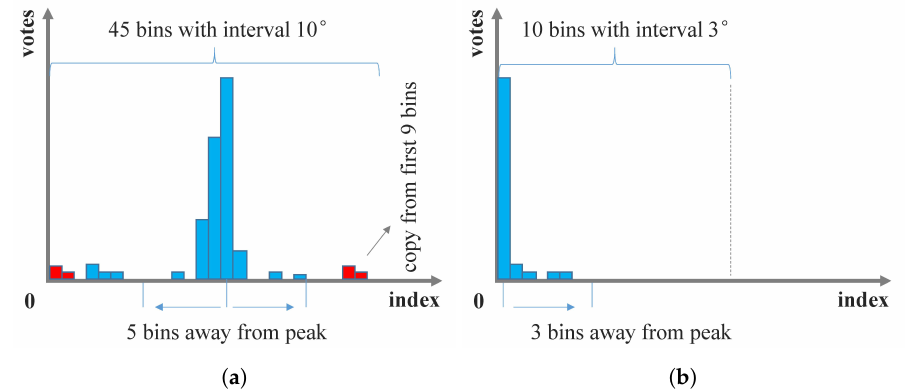
Figure 4. Hough voting for the HMCC: ( a ) direction; ( b ) direction change. Table 3. The configuration of the tiling